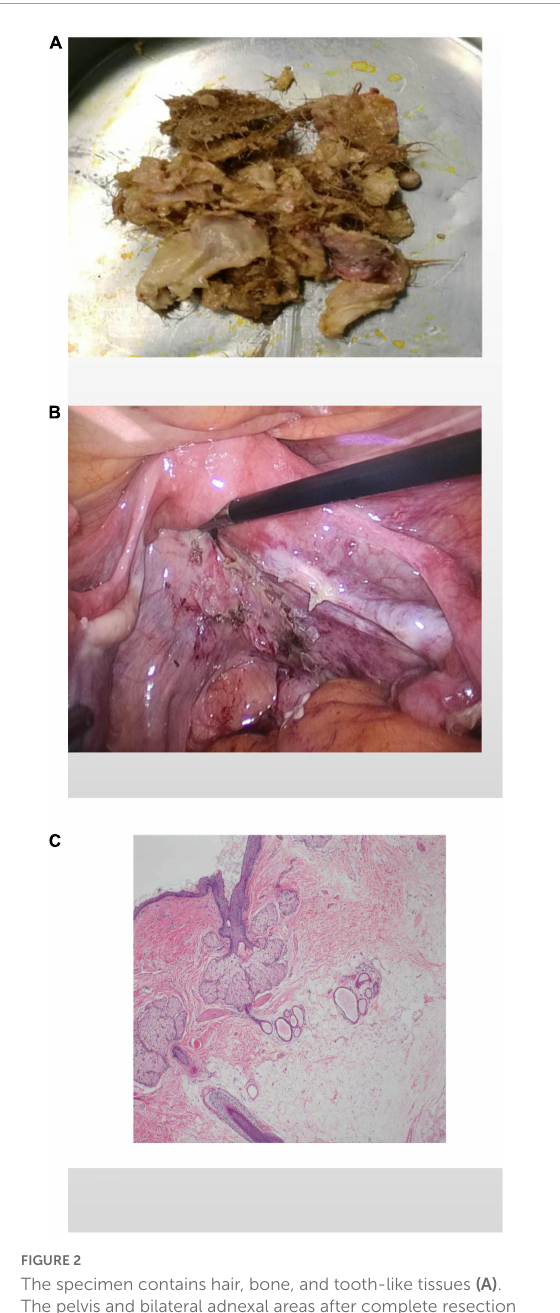
FIGURE2 The specimen contains hair, bone, and tooth-like tissues (A) . The pelvis and bilateral adnexal areas after complete resection of the teratoma showed no obvious abnormality (B) . Histological pictures (C)